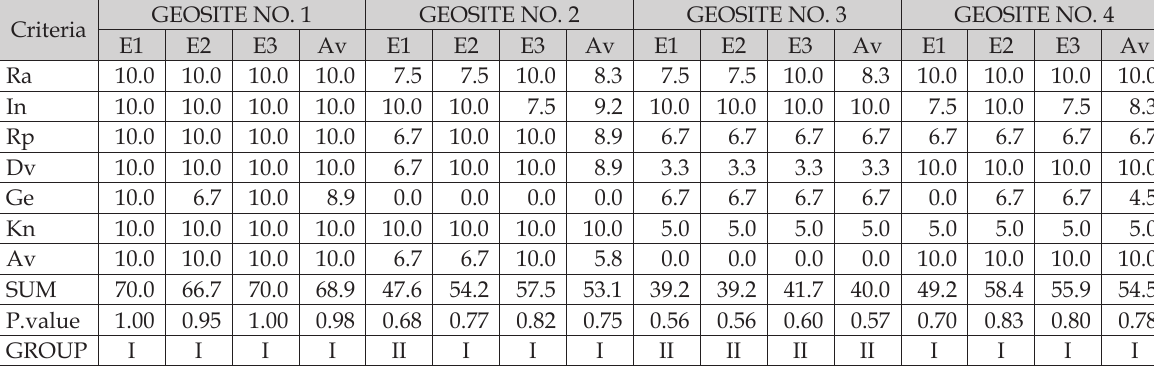
Table 3. Results of the assessment of selected